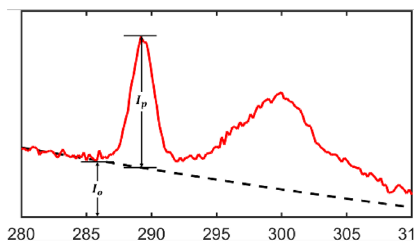
Figure 2. Jump ratio and peak signal noise